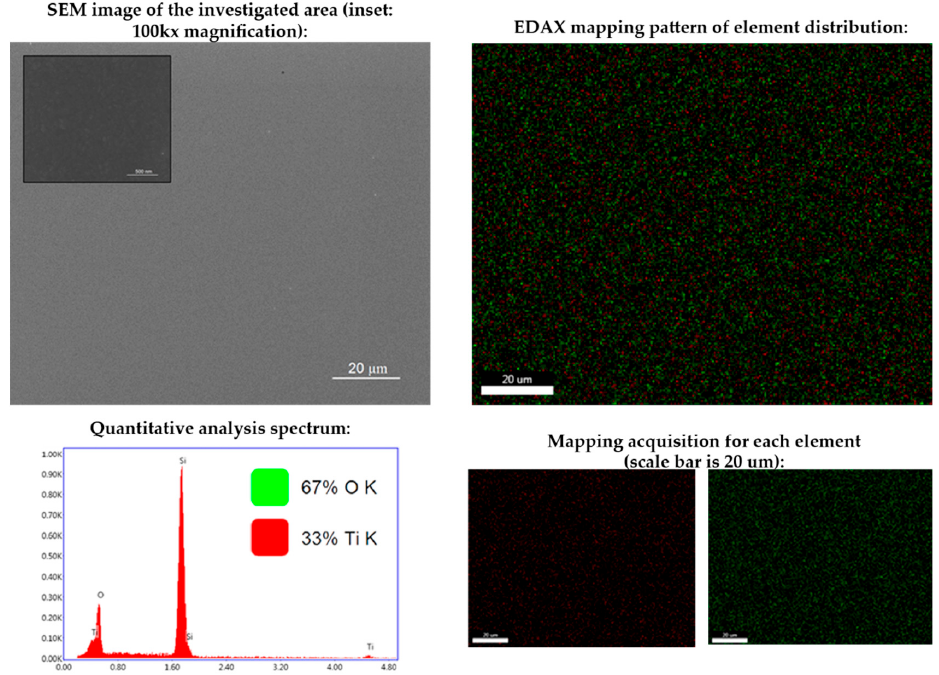
Figure 6. Element distribution mapping at 2000× magnification of the TiO 2 sample deposited under Ar:O 2 = 30:2 sccm flow rate.